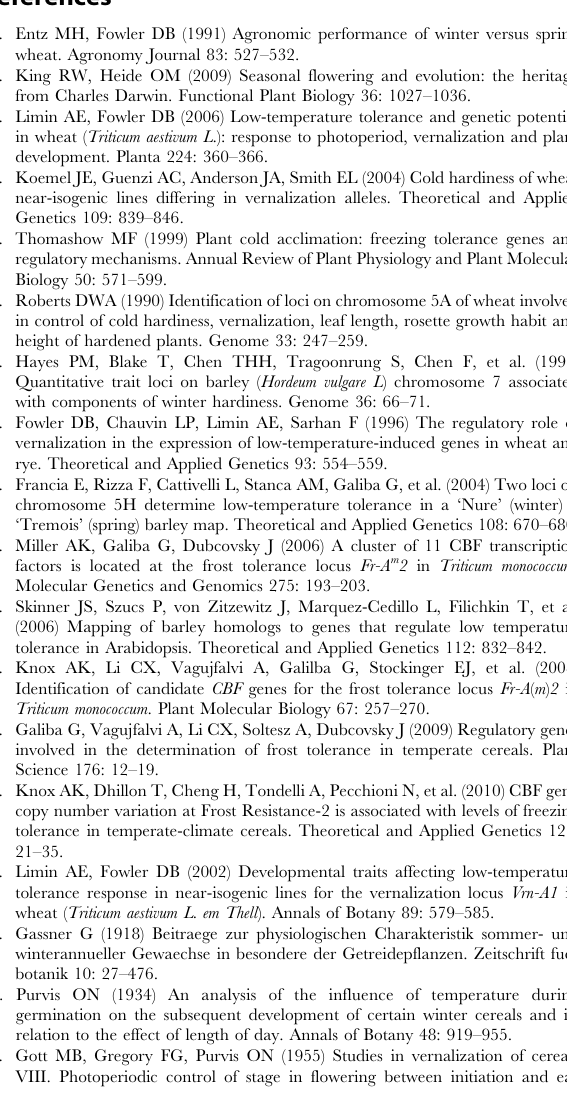
Table S4 Contigs with altered expression in the prolonged cold treatment relative to the short cold treatment. Table S5 Contigs with altered expression after one day after prolonged cold relative to short cold treatment. Table S6 Contigs with altered expression in the prolonged cold treatment relative to one day after prolonged cold treatment.